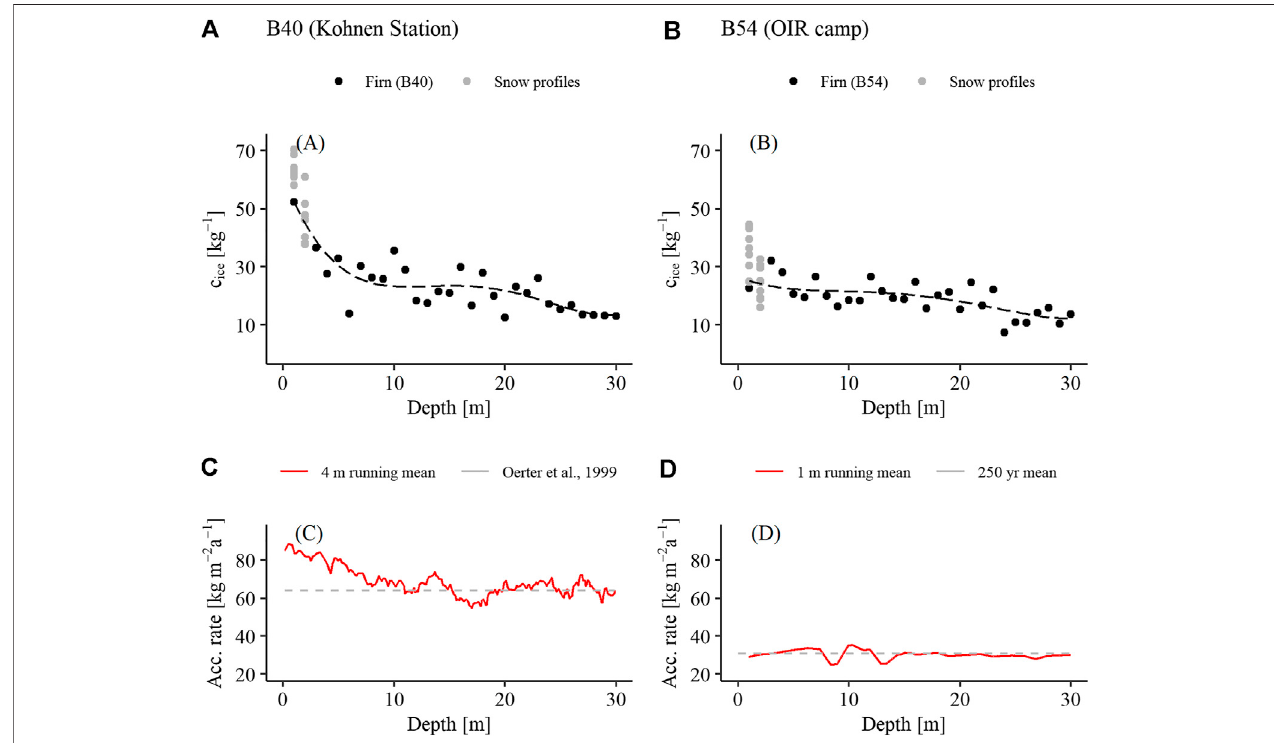
FIGURE 7 | Crust concentration per meter water equivalent (calculated meter by meter) in cores B40 (A) and B54 (B) . The bottom end of each 1 m segment is shown on the x -axis. Thesmoothed dashed curve isapolynomial fi tofgrade 4. Wealso show theaccumulation rateof (C) B40 according to Medley et al. (2018) as well as the long-term mean (Oerter et al., 1999) and of (D) B54 (preliminary results).